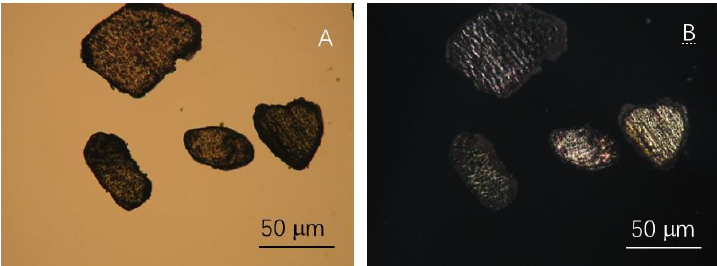
Figure 2. Images of the laver taken with natural ( A ) and polarized ( B ) lights under an optical microscope.